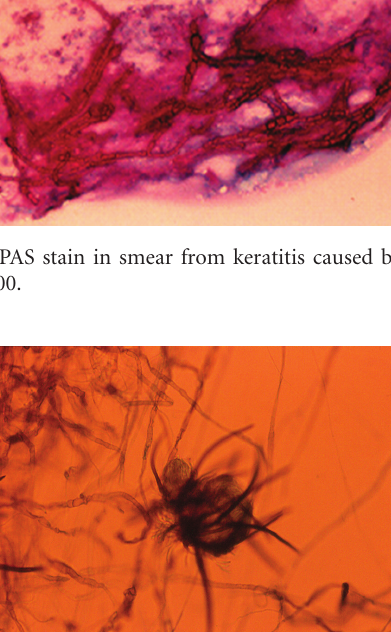
Figure 7: Microscopic view of fungal cells in a corneal sample smear with calcofluor and epifluorescent light × 400.